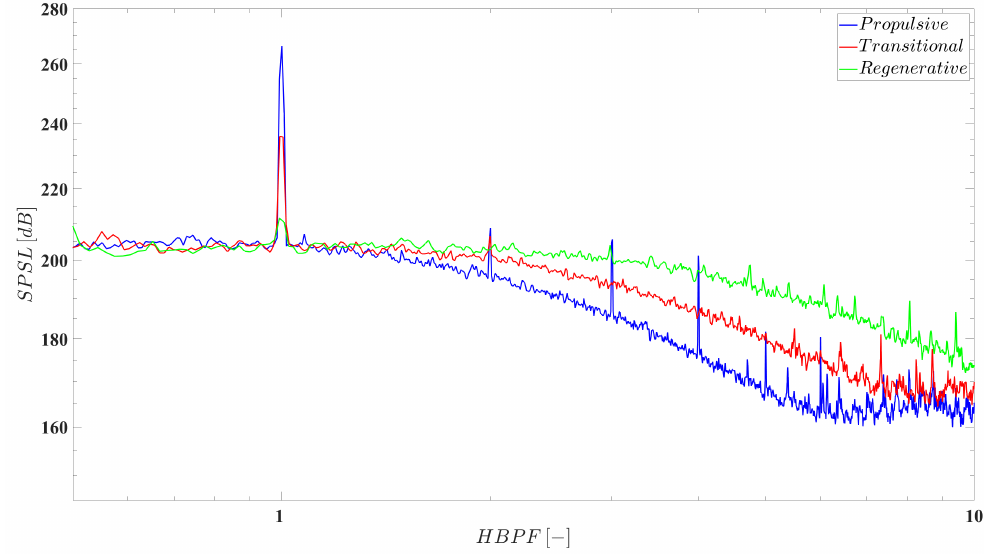
Figure 6. Dimensionless spectra of the near-field pressure signals for each operational